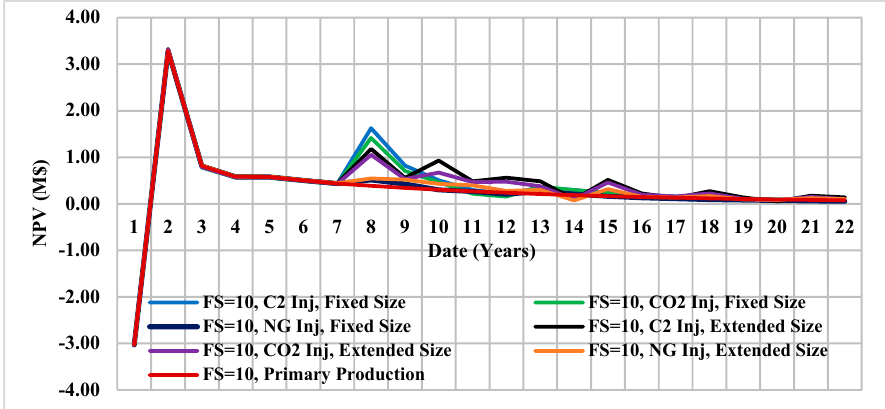
Figure 27. Cumulative NPV of the scenarios for fixed and extended cycles of cyclic CO2, C2 and NG injection as well as natural depletion, FS = 30, Oil API = 31.